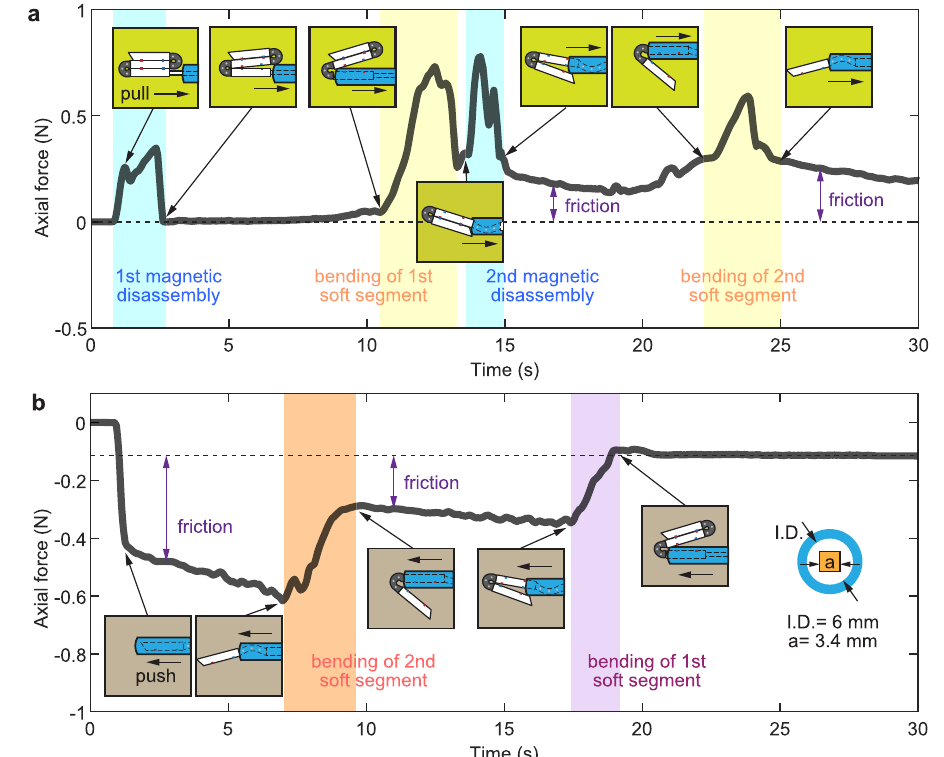
folding process involved bending of the soft segments and magnetic disassembly. Key moments are marked along the force ‒ displacement curve with small inset diagramstoshowtheinstantshapesofMaSoChains.Moreinformationcanbeseen in Supplementary Movie 8 and the supplementary